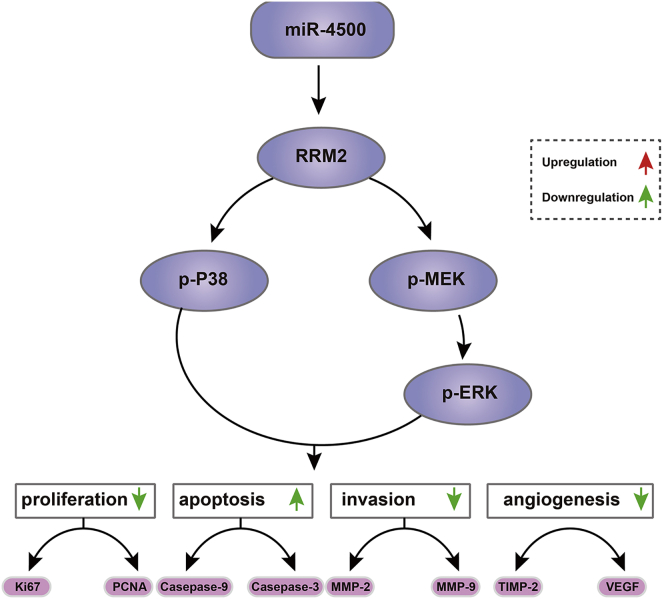
The Mechanism of miR-4500 in Breast Cancer Cells with the Involvement of RRM2 and the MAPK Signaling PathwayOverexpression of miR-4500 downregulates RRM2 to inhibit the activation of the MAPK signaling pathway, thus inhibiting proliferation, invasion, migration, and tumor angiogenesis and promoting apoptosis of breast cancer cells.